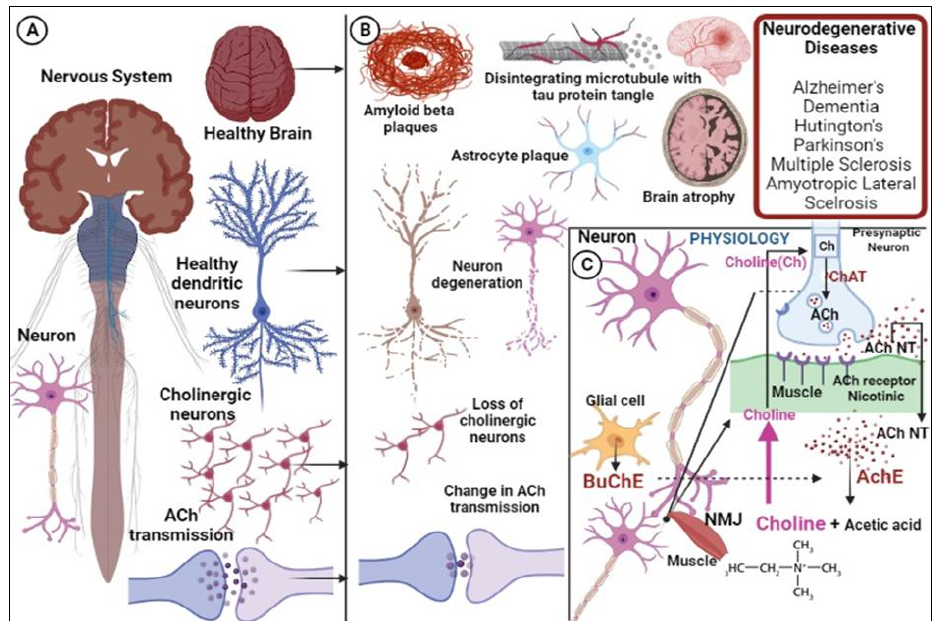
Figure 1. ( A ) Schematic illustration of a healthy brain and nervous system with a focus on cholinergic neurons and circuits in the general population. ( B ) Alterations/changes in cholinergic function and related pathologies spurred by those changes in neurons and neuronal circuits. ( C ) ACh’s function at synapses: The primary precursor for the synthesis of Ach is choline. Choline and Acetyl-CoA are combined to create Ach by the action of choline acetyltransferase (ChAT). ACh controls cholinergic signaling in various parts of the brain and binds to nicotinic or muscarinic receptors on postsynaptic neurons/tissues, including muscles (NMJ). The NMJ’s primary function is to translate the temporal sequence of motor neuron action potentials (APs) into muscular contractions. The activity of AChE causes extra ACh at synapses to be converted to choline and acetic acid. BuChE found in the glial cells is also involved in ACh metabolism. Transporters are then used to recycle choline back to the neuron and nerve terminal for further release.